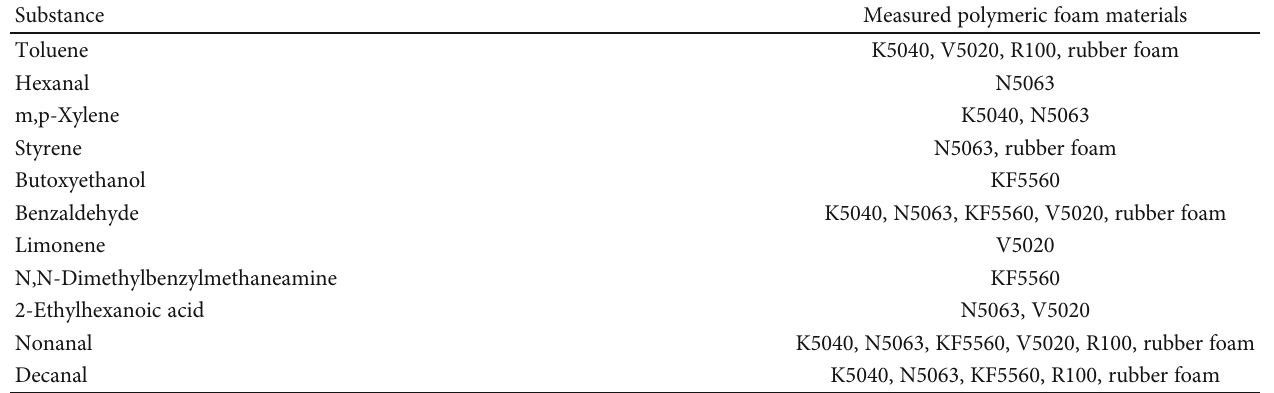
Table 5: Characteristic substances recorded by olfactometry for speci fi c